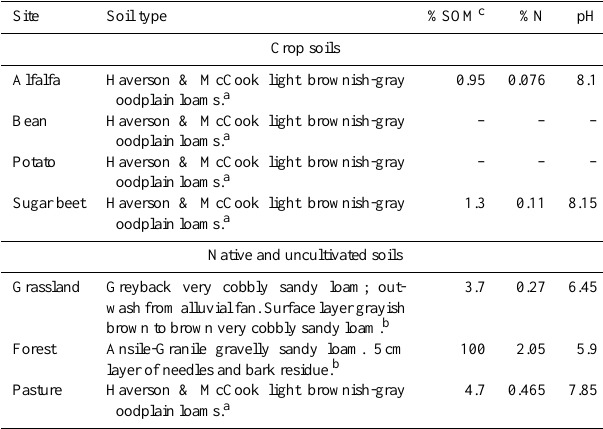
Table 1b. Characterization of soil